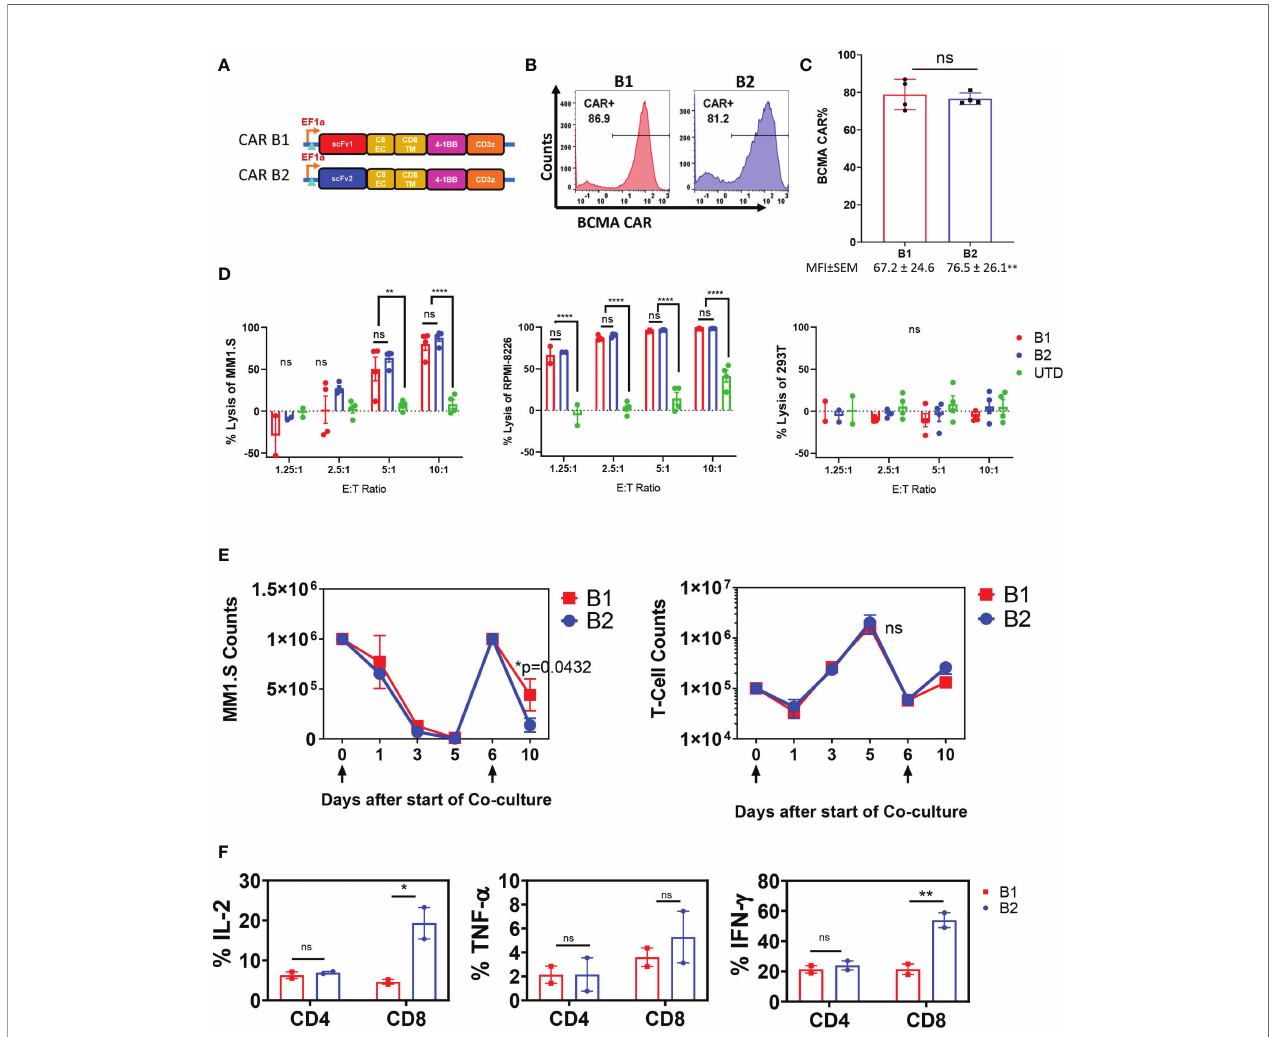
FIGURE 1 | Characterization of B1 and B2 CAR functionality in vitro . (A) CARs B1 and B2 are comprised of fully human scFv linked to the human CD8 extracellular and transmembrane domains, followed by the 4-1BB co-stimulatory domain, and the CD3 z activation domain. (B) Representative fl ow diagrams of CAR T expression from one donor. (C) Mean ± SEM CAR expression from four transduction experiments performed on T cells from different healthy donors are plotted as bars, and the corresponding mean fl uorescence intensity values (MFI) are noted below each bar. Statistical signi fi cance was determined by Student t-test, ns- non- signi fi cant. Transduction at MOI 10 for B2 and MOI 40 for B1 was used in order to achieve similar CAR expression. (D) Overnight killing assay on BCMA-positive MM lines MM.1S and RPMI-8226, and BCMA-negative line 293T. The cytotoxic capacity of B1 and B2 CAR T-cells were determined by co-culturing the CAR T-cells with target cells for 18-20 hours at the ETT ratios shown. The percent cytotoxicity was determined based on the luciferase activity of the remaining target cells in the co-culture after incubation with the CAR T-cells. Mean +/- SEM of four separate experiments with T cells from different donors, each performed in triplicate, are shown. Statistical signi fi cance was determined by two way ANOVA with Tukey ’ s multiple comparisons post-hoc test; ns-non signi fi cant, **p<0.01, ****p<0.001. (E) Long-term co-incubation study with BCMA CAR T cells and MM.1S-GFP target cells. Data are presented as mean+/- SEM of CAR T cells from two separate donors tested in long-term co-incubation experiments. Target cells at ETT ratio of 0.1 were added on days 0 and 6, as indicated by arrows below the x-axis. The absolute counts of T cells and target cells were assessed by fl ow cytometry at the indicated time points by quantifying the number of CD3+ cells and GFP+ cells, respectively. Statistical signi fi cance was determined by two way ANOVA with Tukey ’ s multiple comparisons post-hoc test. (F) Elaboration of cytokines IL-2, TNF- a , and IFN- g by CAR T cells on day 11 of the long-term co-culture experiment was determined by intracellular staining of in CD3+ cells and fl ow cytometric analysis. Data represent mean +/-SEM of two separate long-term experiments, using CAR T cells from different healthy donors. Statistical signi fi cance was determined by two way ANOVA with Sidak ’ s multiple comparisons post-hoc test; *p<0.05, **p<0.01, ns, non-signi fi